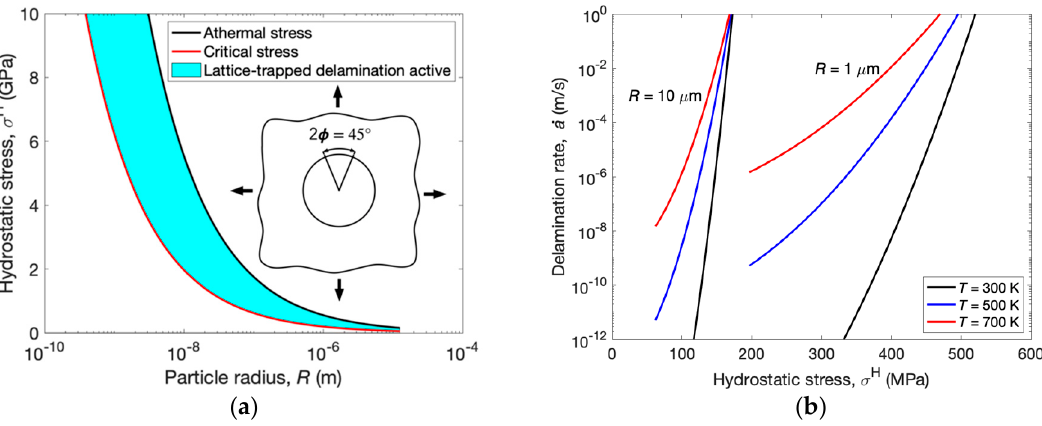
Figure 12. Predictions of lattice-trapped delamination for a crack with 𝜙 = 22.5 ∘ . ( a ) Stress range over which lattice- trapped delamination may operate. ( b ) Lattice-trapped delamination rates for particles of radius R = 1 µ m and 10 µ m at three temperatures.